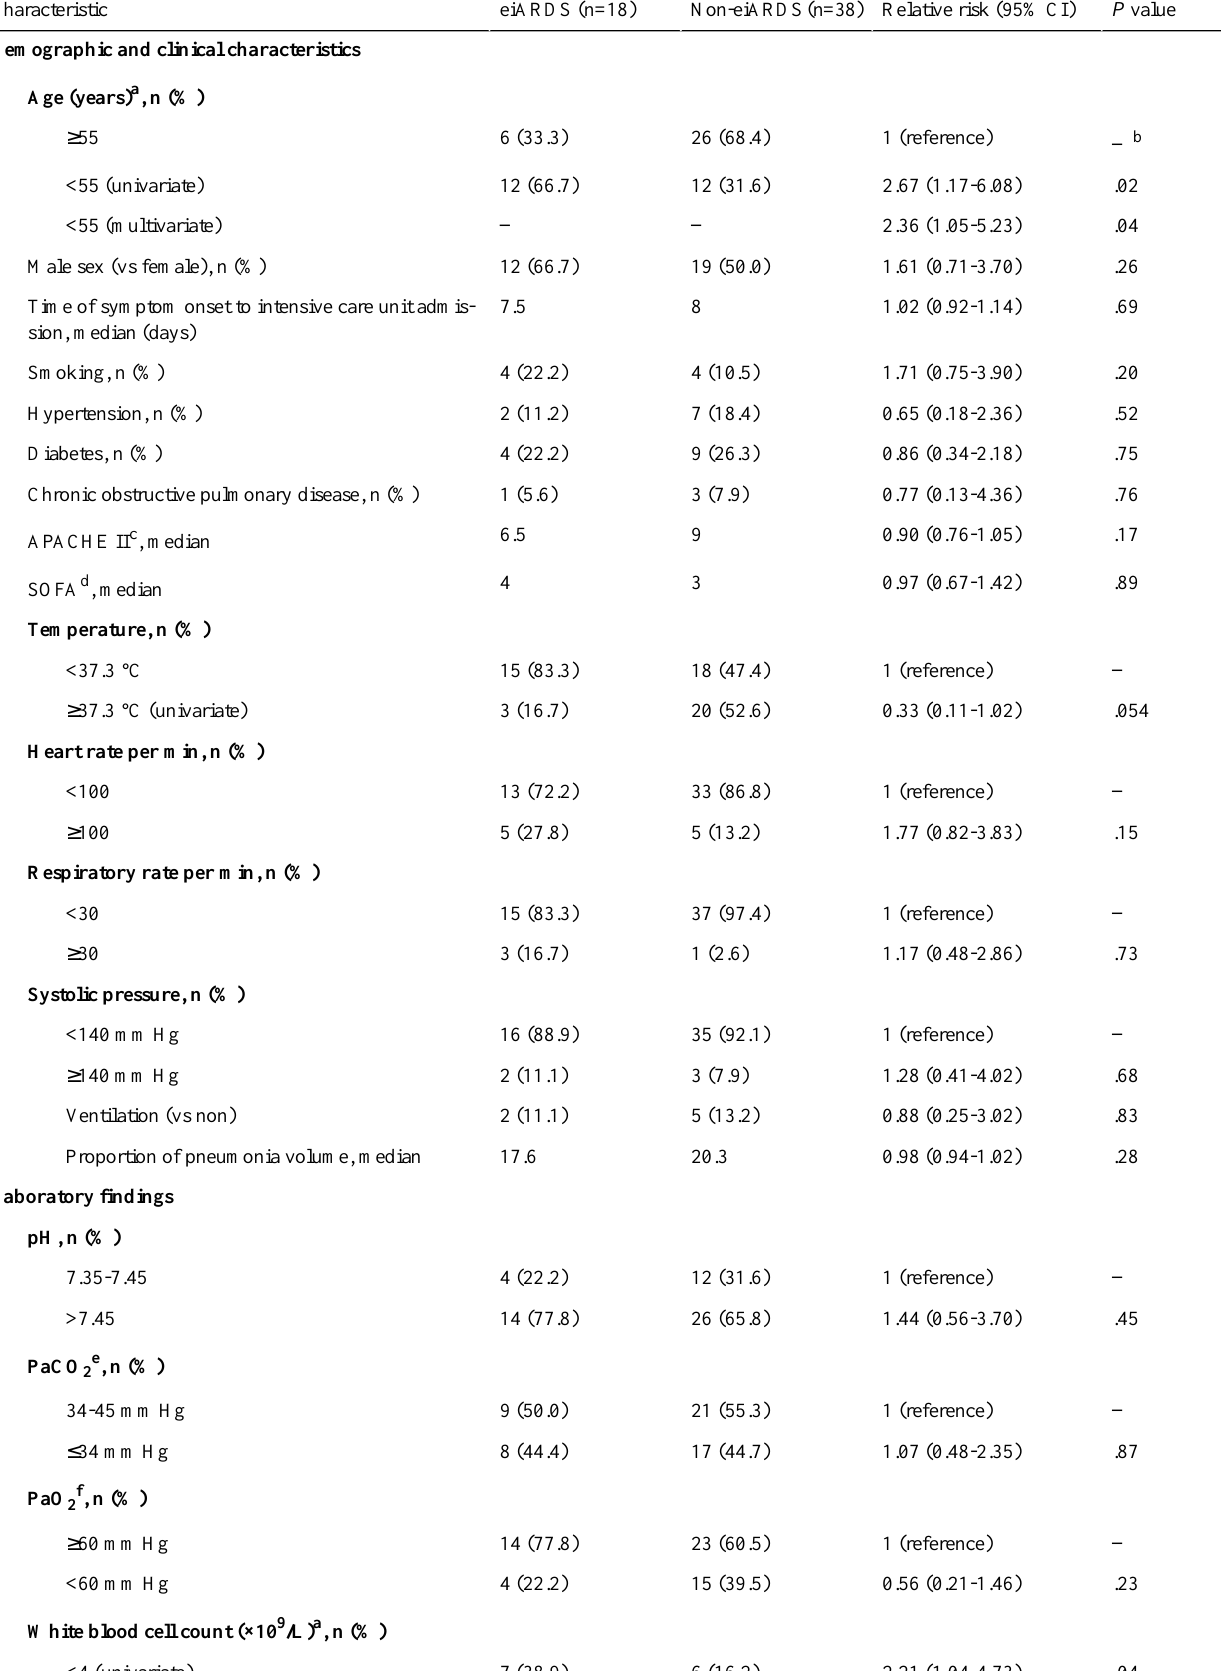
Table 3. Univariate and multivariate analysis of predictors for the early improvement of acute respiratory distress syndrome (eiARDS) in patients with COVID-19 in Chongqing, China (from January 21 to March 15,